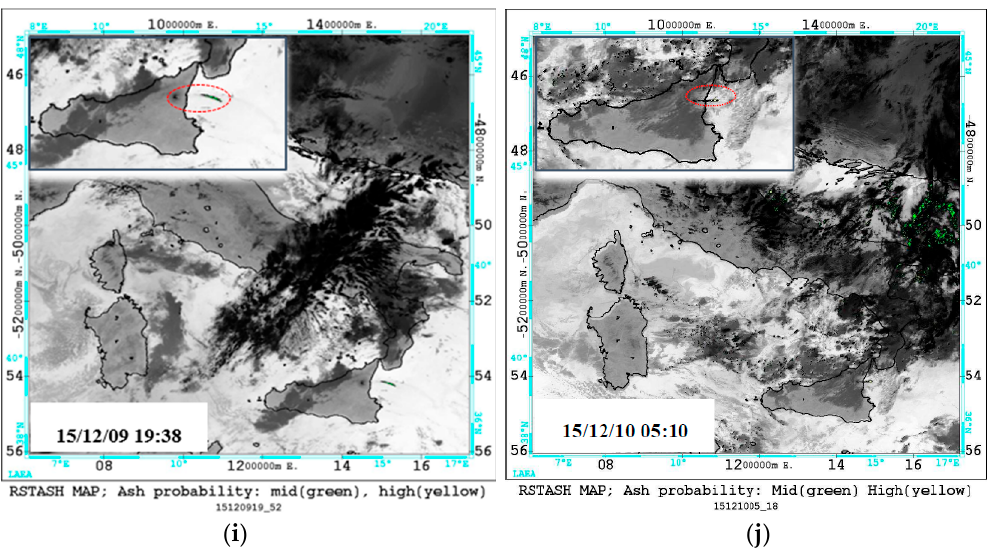
Figure 8. RST ASH maps from AVHRR data of 8–10 December 2015 showing an ash plume (green/yellow pixels) dispersing from Mt. Etna area towards sea regions. On the top-left side of each panel, the zoom of ash-affected areas (dotted red ellipse indicates a small plume). ( a ) 8 December at 05:33 UTC; ( b ) 8 December at 08:37 UTC; ( c ) 8 December at 19:59 UTC; ( d ) 9 December at 01:50 UTC; ( e ) 9 December at 05:22 UTC; ( f ) 9 December at 08:16 UTC; ( g ) 9 December at 09:03 UTC; ( h ) 9 December at 16:31 UTC; ( i ) 9 December at 19:38 UTC; ( j ) 10 December at 05:10 UTC.